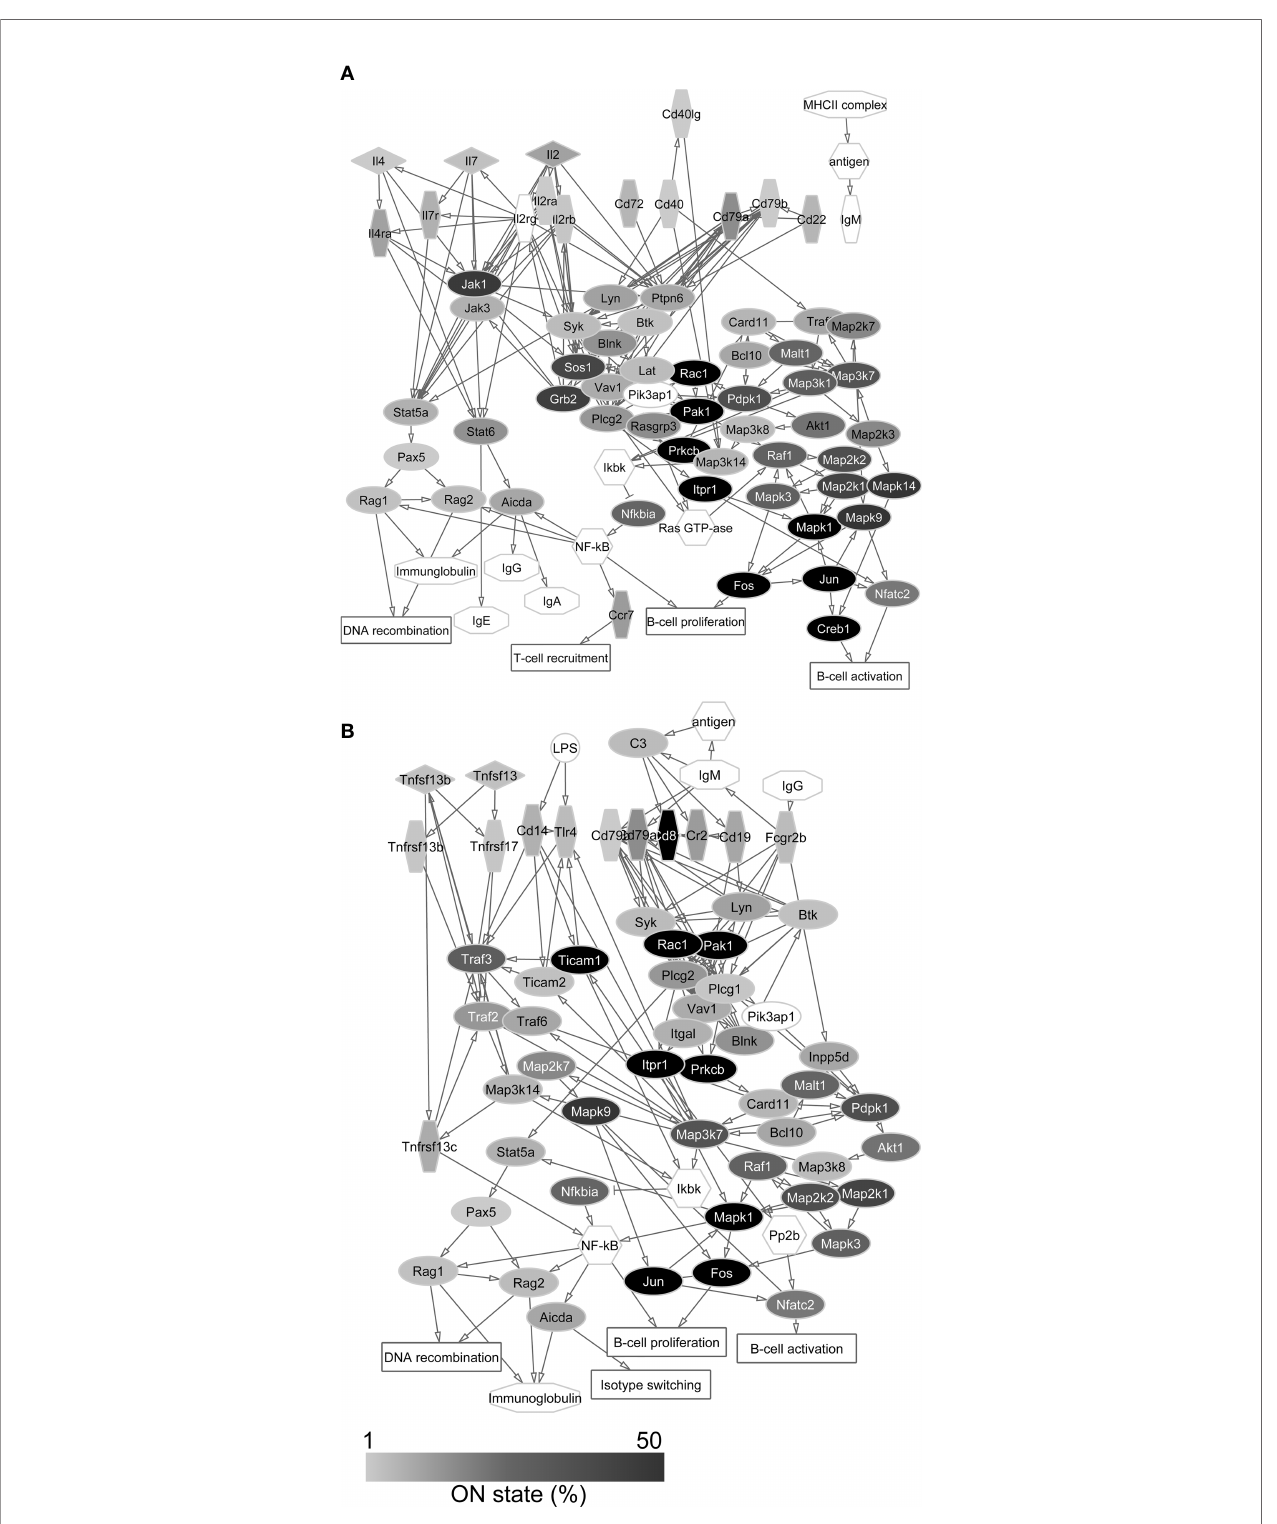
FIGURE 4 | Protein-protein interaction networks of T cell dependent (A) and T cell independent (B) B cell activation. Gray scale shows the percentage of neurons that expresses the transcript of each protein in the single-cell sequencing data (ON state frequency). The transcripts of proteins with white label were not found in the sequenced neurons. In these networks, genes encoding signal regulatory proteins show high ON state frequencies as